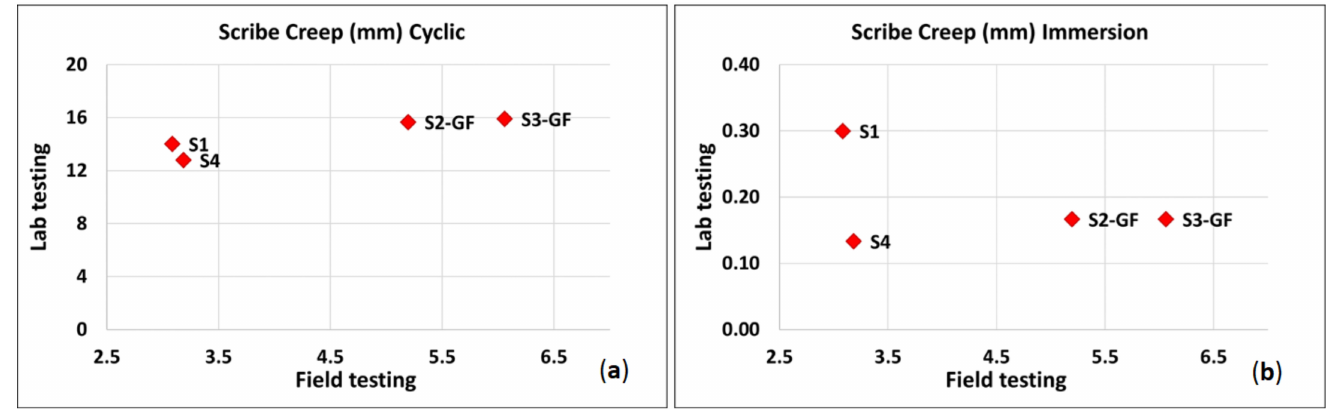
Figure 8. Scribe creep after accelerated aging, ( a ) cyclic, ( b ) immersion, plotted as a function of scribe creep after field exposure.